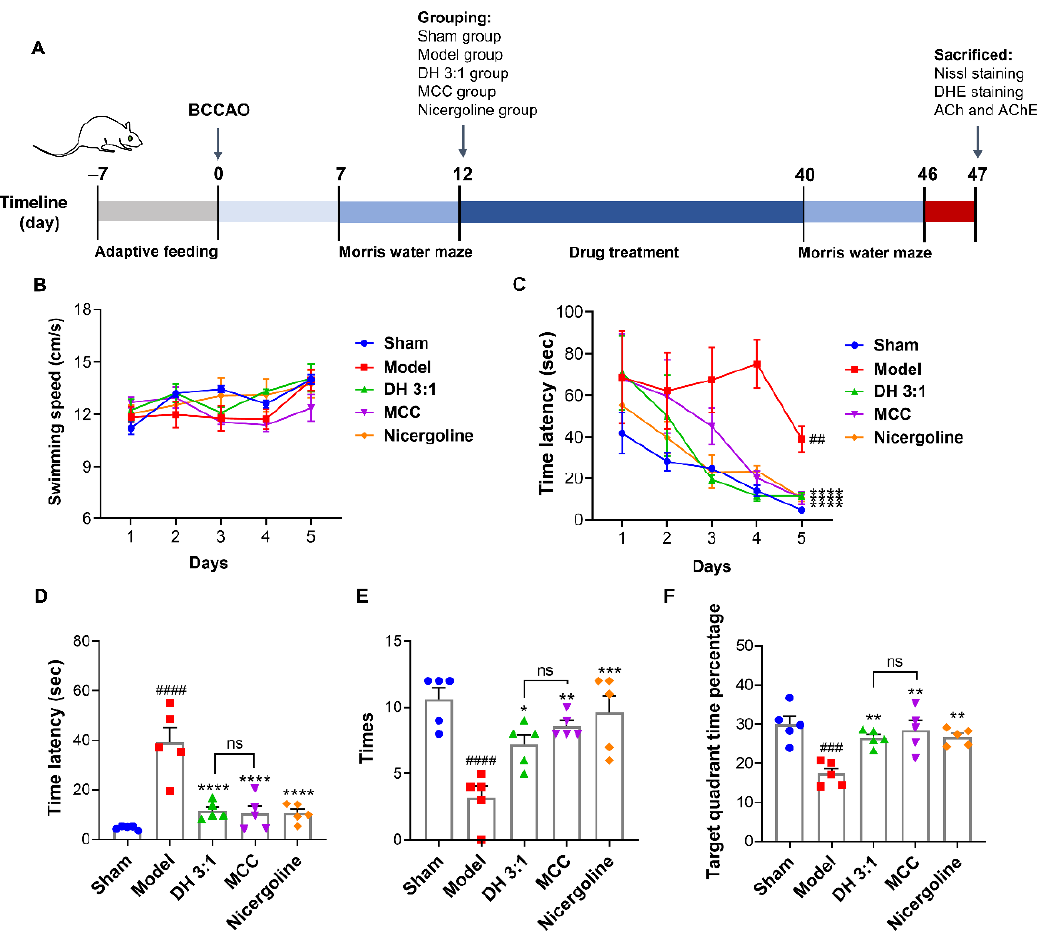
Figure 6. The MCC of the DH herbal pair improved cognitive impairment in VaD rats. ( A ) The time schedule of animal experiment protocols. ( B , C ) The swimming speed and the escape latency of rats from day 41 to day 45 in the Morris water maze (MWM) test were recorded. ( D ) The escape latency on day 45 in the MWM. ( E , F ) The platform crossing times and the target quadrant time percentage within 120 s were recorded on day 46 after the platform was removed. The data are presented as mean ± SEM (n = 5). DH: Danshen-Honghua; MCC: multi-component combination. * p < 0.05, ** p < 0.01, *** p < 0.001, **** p < 0.0001 vs. model group; ## p < 0.01, ### p < 0.001, #### p < 0.0001